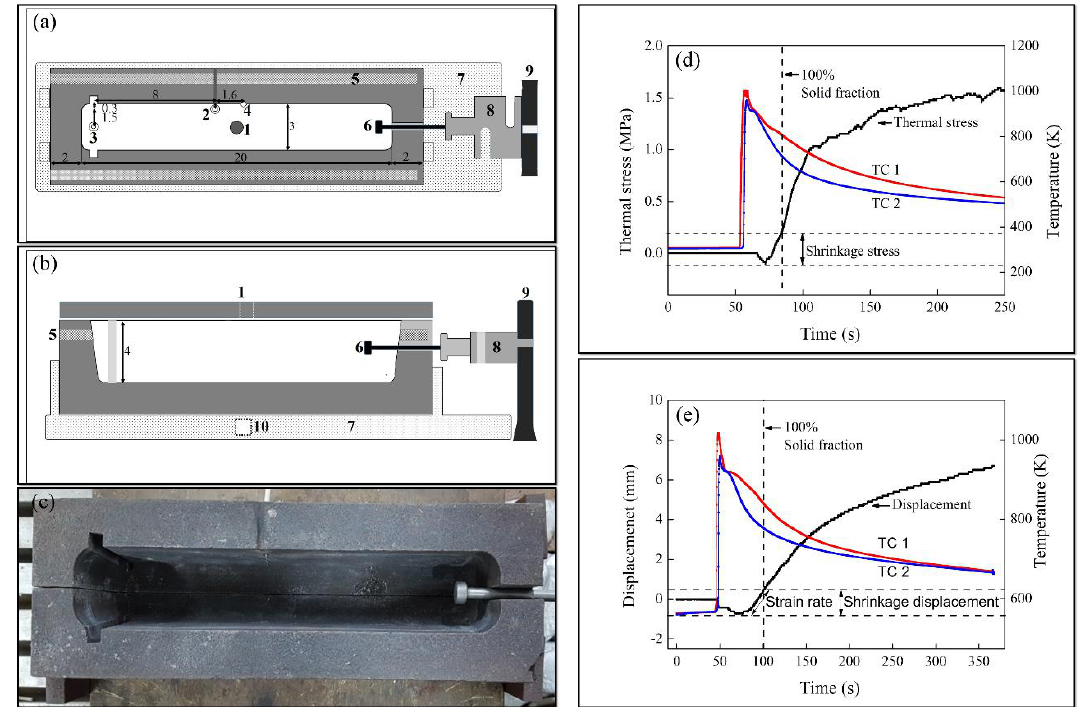
Figure 2. Schematic diagram showing ( a ) top and ( b ) side views of the mold used to measure thermal stress and shrinkage starting temperature (SST): (1) injection hole, (2) thermocouple 1, (3) thermocouple 2, (4) the point at which the temperature of melt in the mold was estimated, (5) inner heaters, (6) pin, (7) heating plate, (8) load cell, (9) fixed column, (10) thermocouple 3. ( c ) Image of the top view of the actual mold. Typical profiles of ( d ) thermal stress and ( e ) shrinkage displacement measured in the mold. Thermocouple 1 and 2 were fixed at 20 mm above the bottom of the mold.